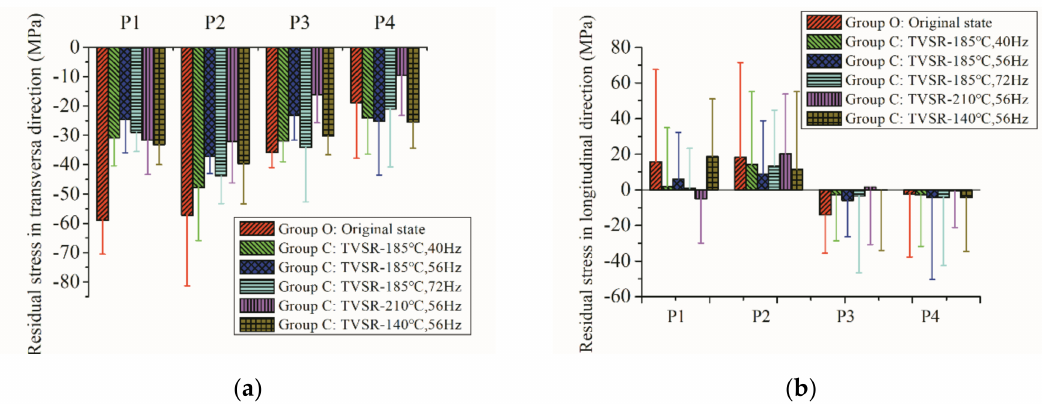
Figure 7. Stresses in the transversal direction ( a ) and longitudinal direction ( b ) at each measurement point, before and after thermal and vibratory Stress relief (TVSR) treatment at different parameters.